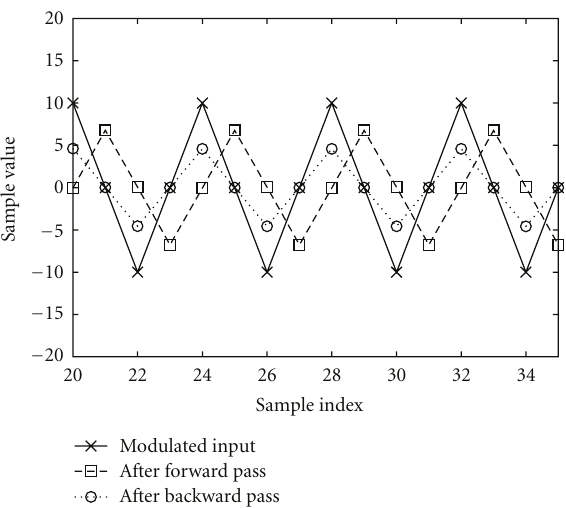
Figure 5: Illustration of a result of the forward pass u t (square marks) during a Gaussian filtering on a modulated input i mod t (cross marks). Only the amplitude and phase of the signal are changed. After the backward pass (circle marks), the phase is synchronized again with the modulated input as the Gaussian filtering is fully computed now. The period of signal is kept unchanged after each of the two